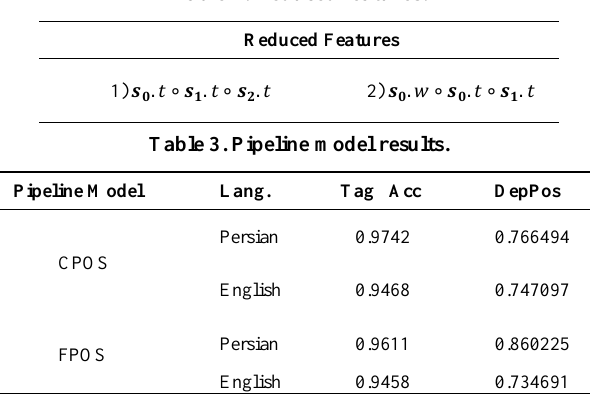
Table 2. Reduced features.